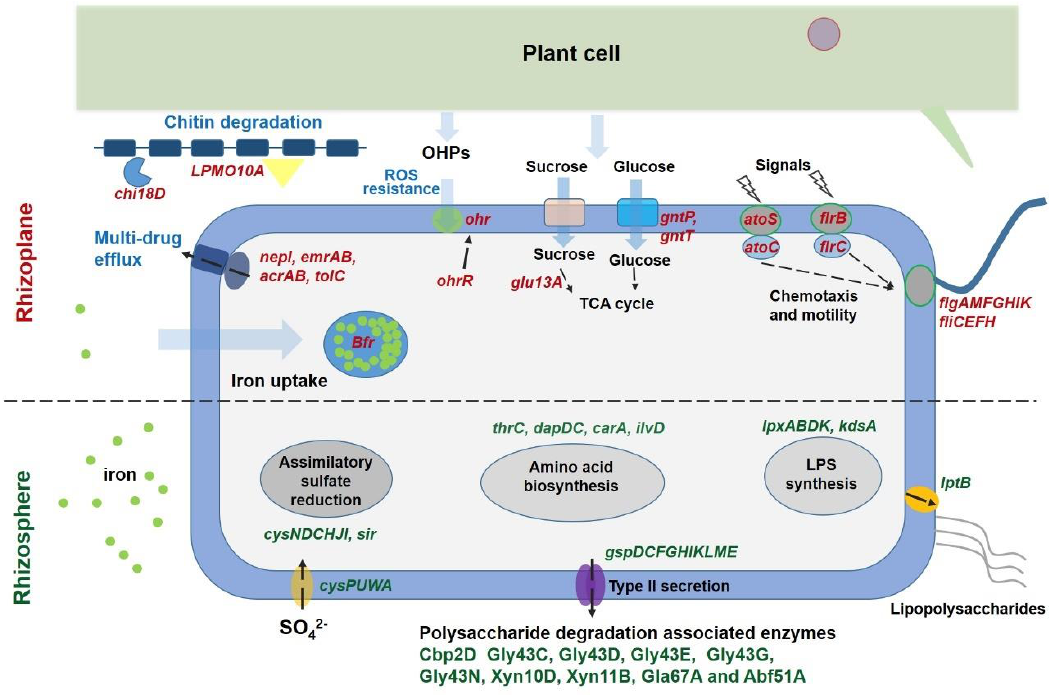
Figure 3. Overview of the genes with expression level differing between rhizoplane and rhizosphere habitats. Genes with higher expression level in the rhizoplane niche are red colored, while genes with higher expression level in the rhizosphere habitat are dark green colored. Iron is indicated by green circles, chitin is indicated by blue line-linked rectangles. The arrows denote influx and efflux of compounds.